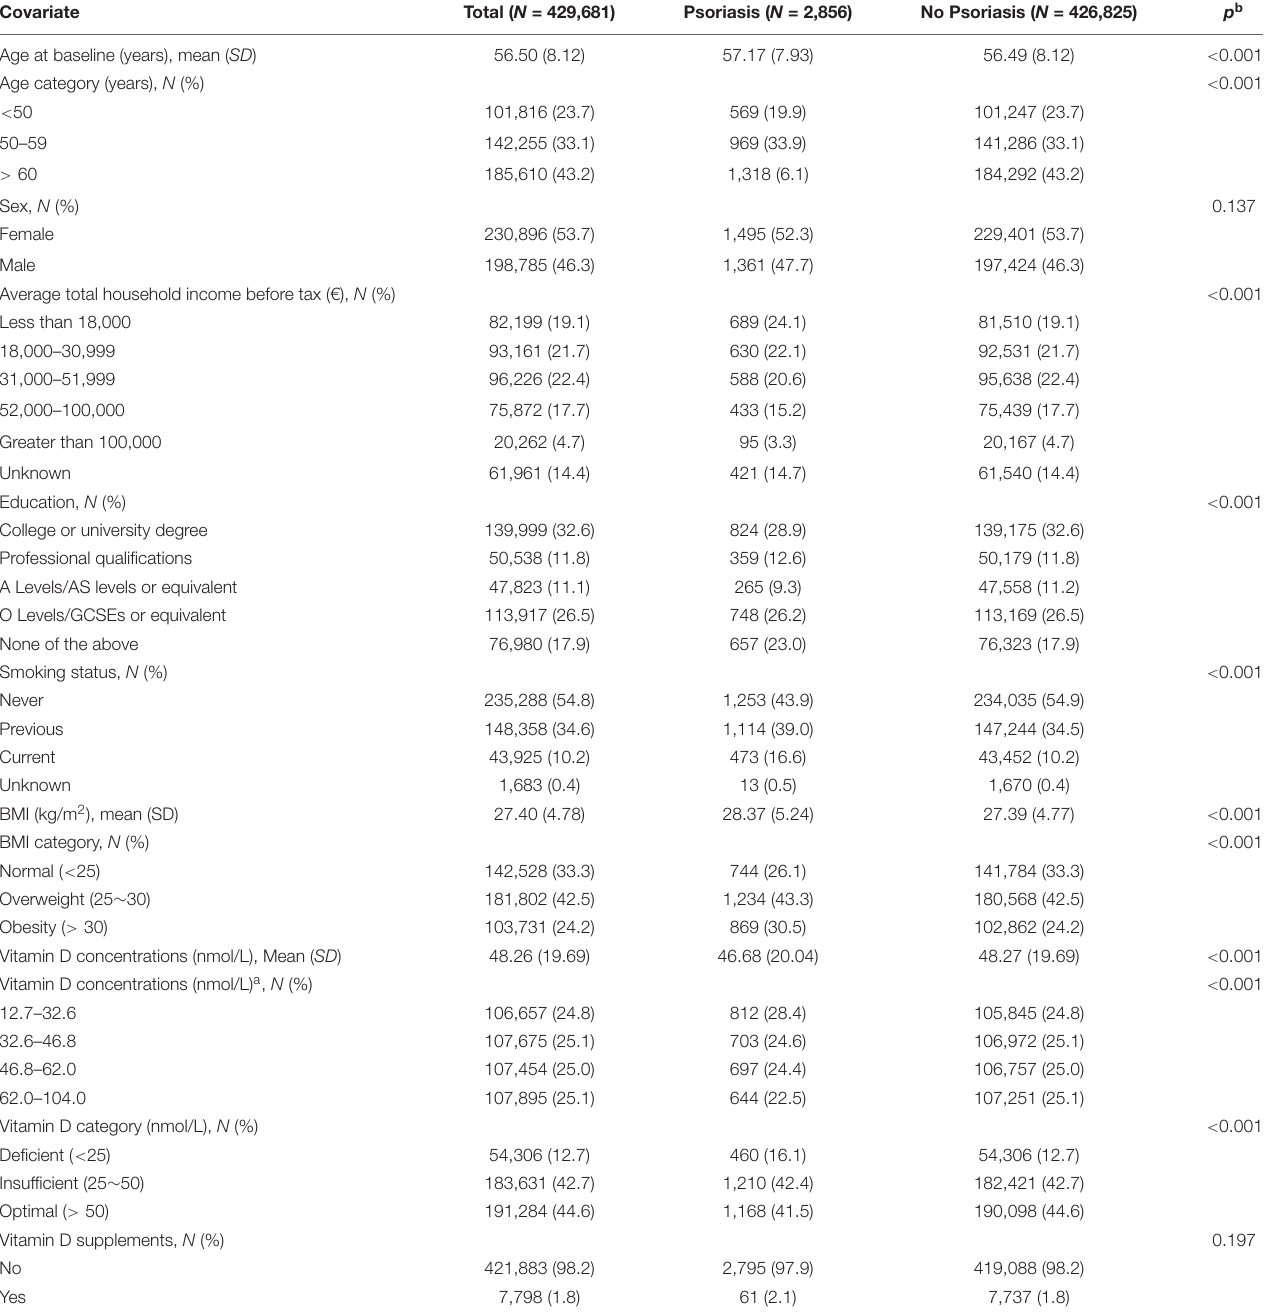
TABLE 1 | Characteristics of participants from the UK